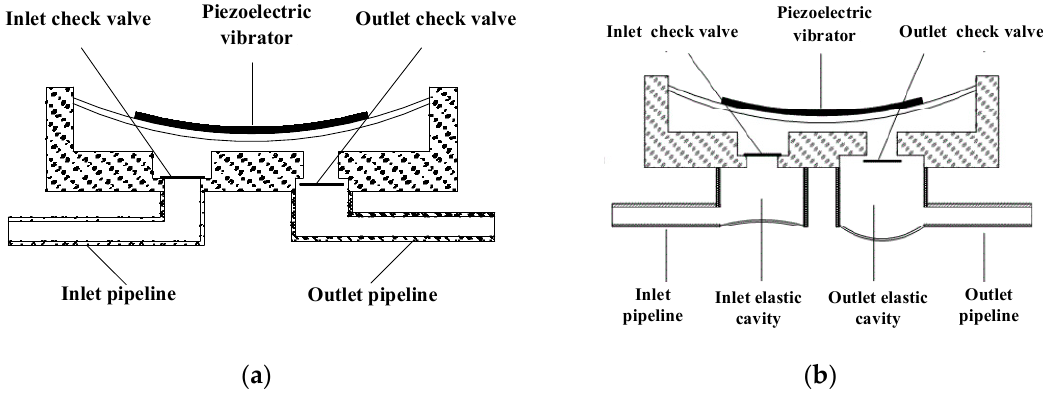
Figure 1. Schematic diagram of inlet and outlet structure optimization. ( a ) Piezoelectric pump with traditional inlet and outlet, ( b ) piezoelectric pump with elastic inlet and outlet.